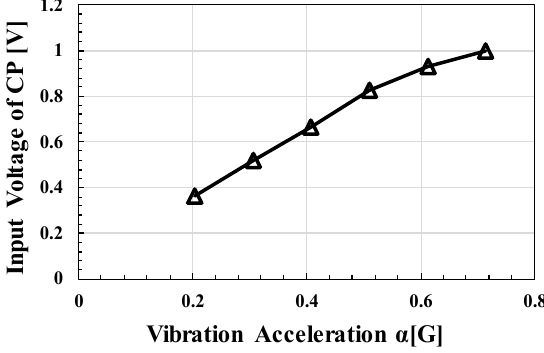
Figure 23. Measured V DD as a function of α ( V OUT = 2 V, f IN = 195 Hz, f CLK = 5 MHz).